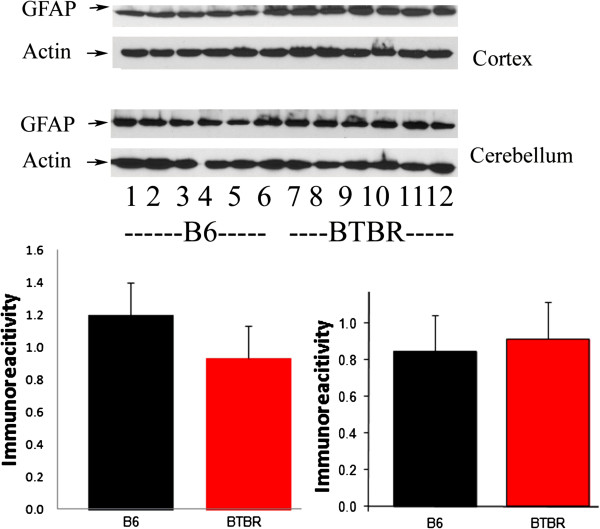
GFAP protein expression in the frontal cortex of BTBR and B6 mice. Western blot analyses were carried out on frontal cortex and cerebellum homogenates from six BTBR mice and six age-matched B6 mice using anti-glial fibrillary acidic protein (GFAP) antibody (dilution 1:1000). The blots on cortex and cerebellum were quantified respectively after being normalized by actin (lower left bar figure for cortex and lower right bar figure for cerebellum). Data are shown as mean ± standard error (SE).